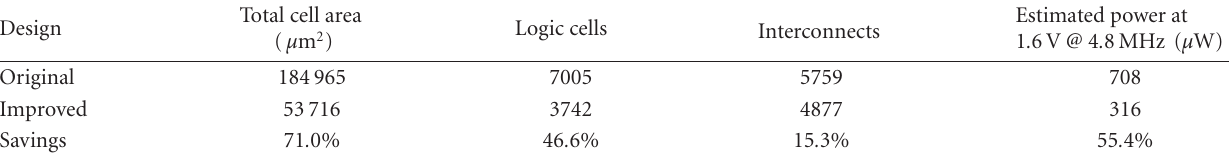
Table 2: Area, cell, net, and power comparison between original and improved filterbank (excludes